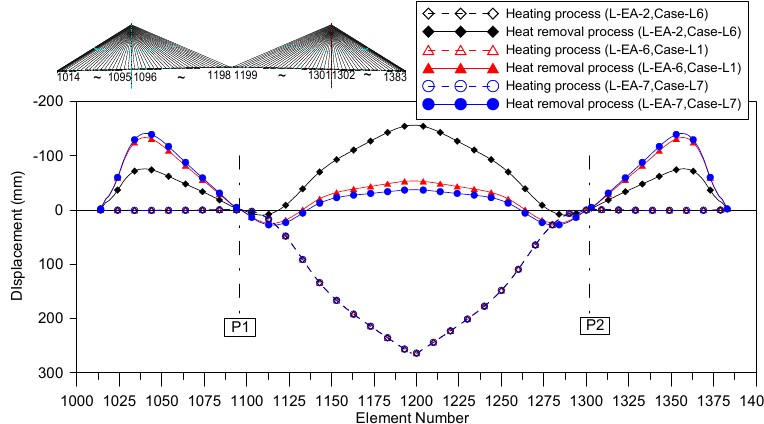
Figure 17. Displacements generated by heating and heat removal with various numbers of earth-anchored cables.